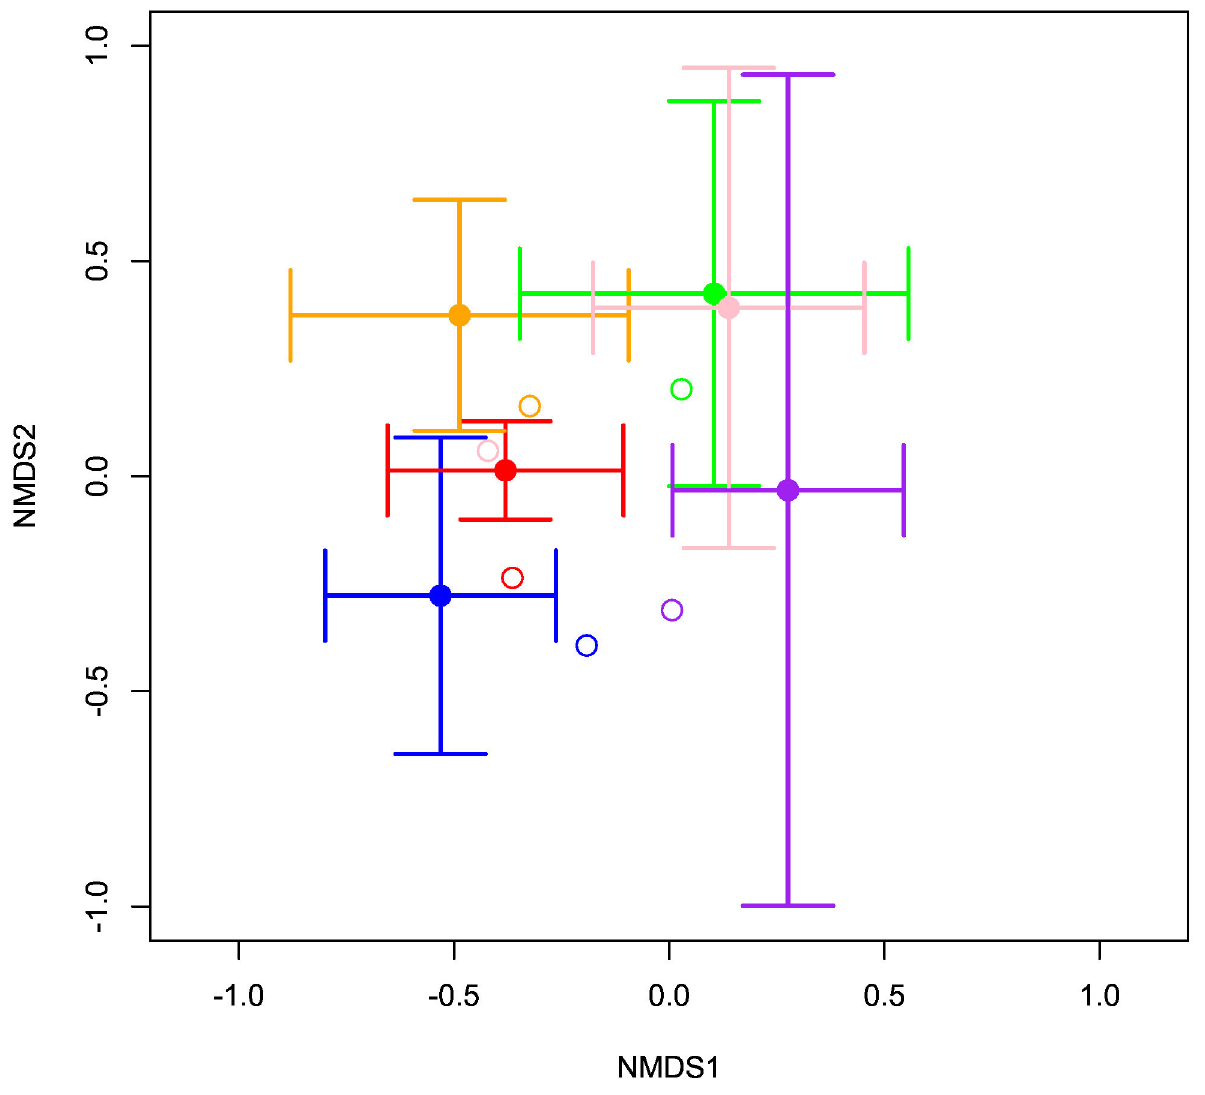
Figure 1. Comparison of individual versus physically pooled samples from six trees using NMDS ordination based on OTUs presence/absence (Stress = 0.25). Full circles and respective bars represent the centroids and two standard deviations of the fungal community recovered by individual bags from inner circles. The open symbols are the correspondent physically pooled sample. Each color indicates an individual tree. Individual and pooled ingrowth bags tend to recover different fungal communities, as pooled samples fall more often than not outside the two standard deviations of communities found in individual bags. This figure shows only the comparison of samples for inner circles. All other comparisons produced similar results and are not